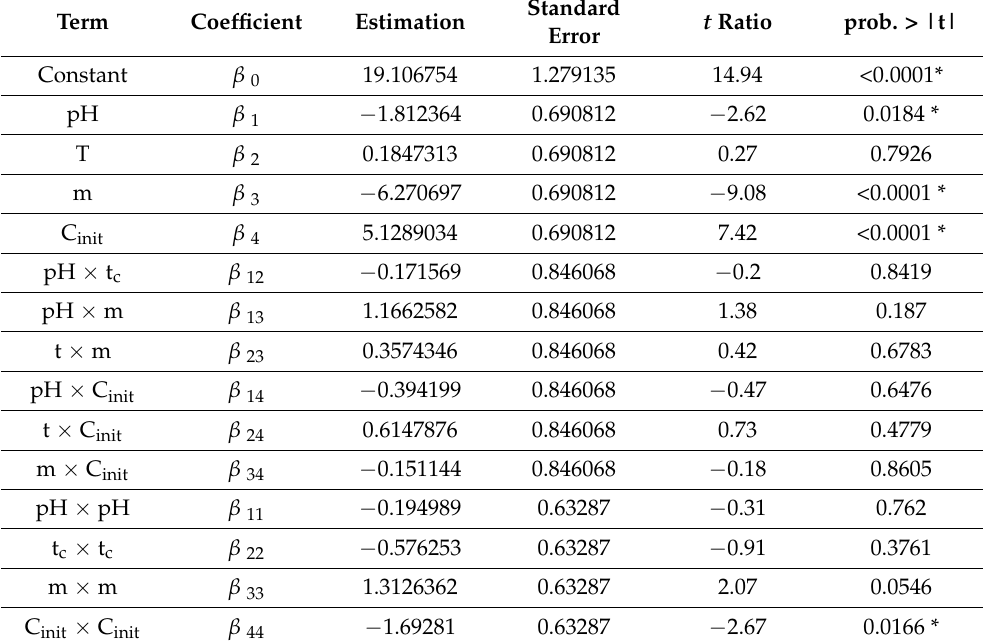
Table 4. Effects of model coefficients relating response to